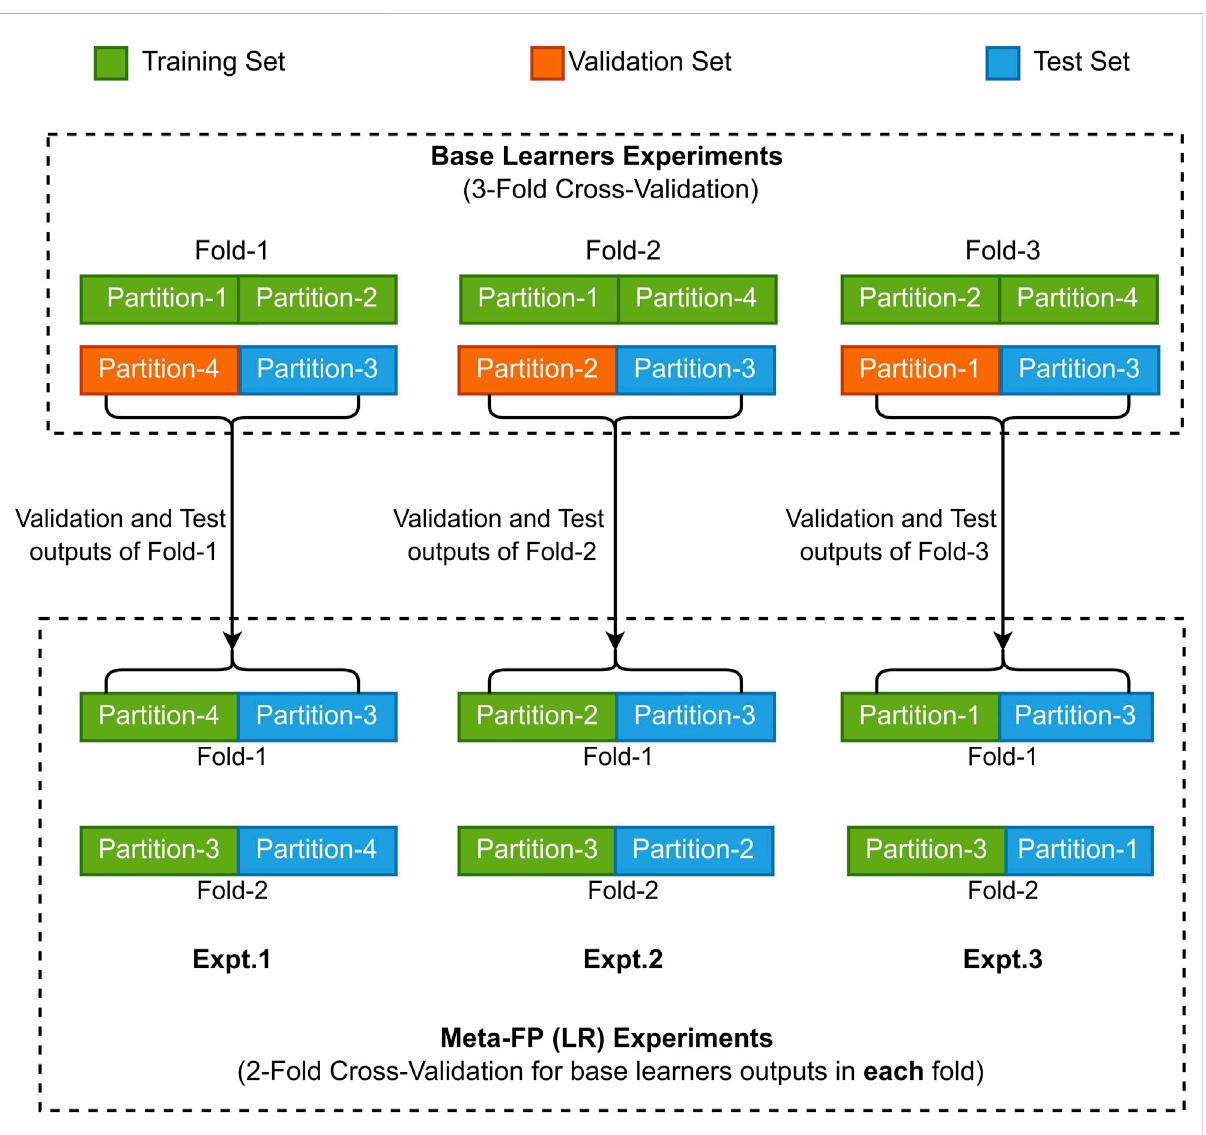
FIGURE 4 Anexperimentaldesigndiagramtodepict the fl owofourexperimentsfor thiswork. Meta-FP experiments for logisticregression (LR)arecross- validated using each fold results of base learners. This results into 2-fold cross-validation in each experiments of